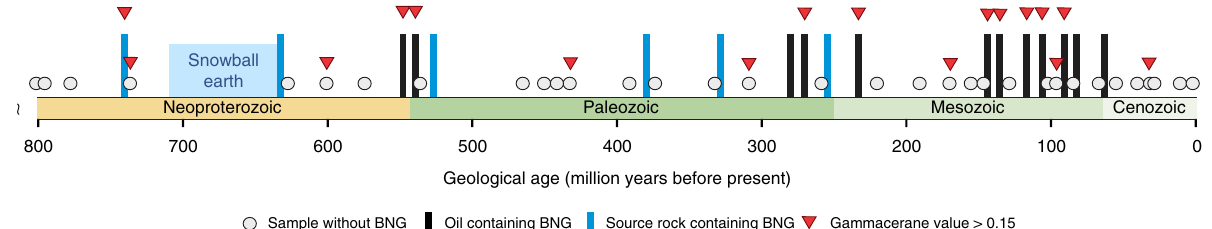
Fig. 3 Secular occurrence of bisnorgammacerane and gammacerane. The molecular marker 25,28-bisnorgammacerane (BNG) occurs sporadically throughout the past 800 Myr of Earth history: positive identi fi cation of BNG in rocks indicated by blue bars, in oils shown by black bars; grey circles indicate absence of BNG in analysed samples. Red triangles indicate those samples with elevated gammacerane/(C 30 αβ hopane + gammacerane) values (>0.15; Supplementary Information), a molecular indicator for water column strati fi cation 27 , especially revealing elevated gammacerane values in many oils, which contain BNG (non-BNG oils 0.13 vs. BNG oils 0.21; n = 105; Supplementary Data